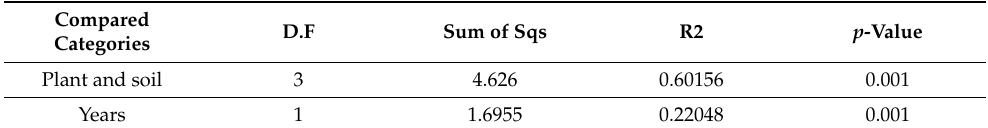
Table 3. Comparison between plant and soil (year 1 and 2) and years according to the Adonis permutation test.